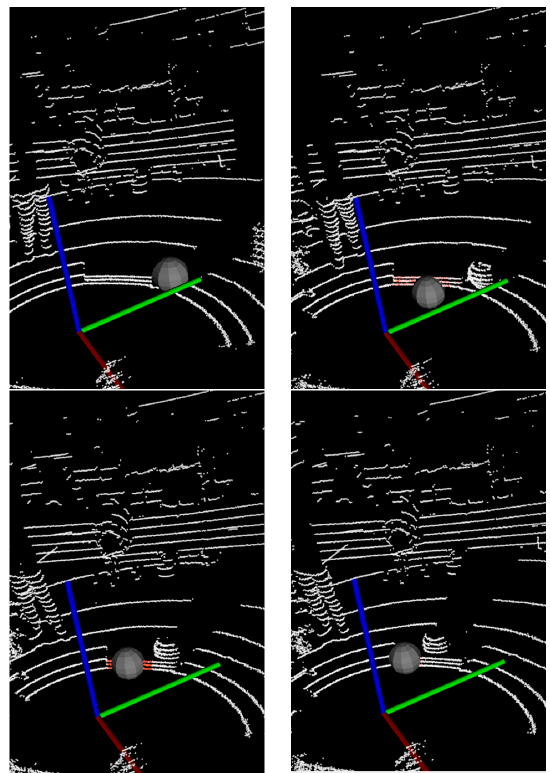
Figure 11. Experimental scenes: ( a ) Occlusion scene; ( b ) Obstacle scene.